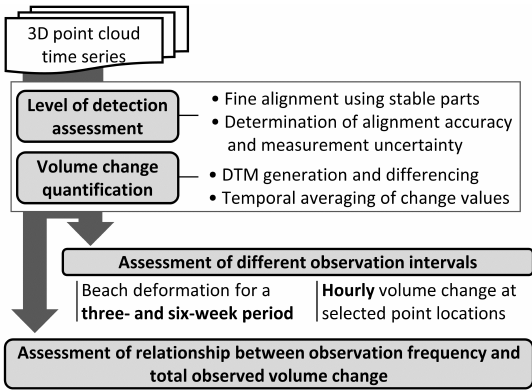
Figure 1. Overview of main analysis